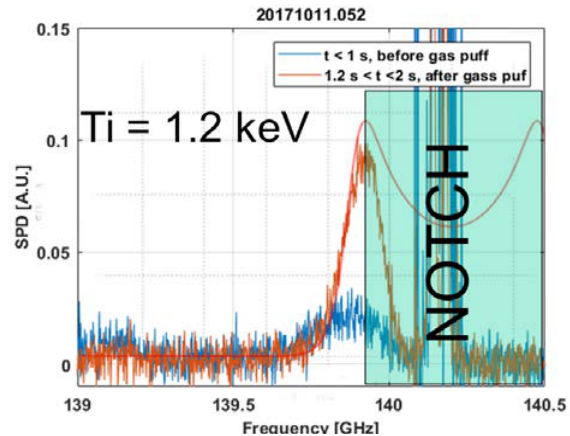
Fig5: CTS spectrum at low density (bleu) and medium density (red) in a Helium